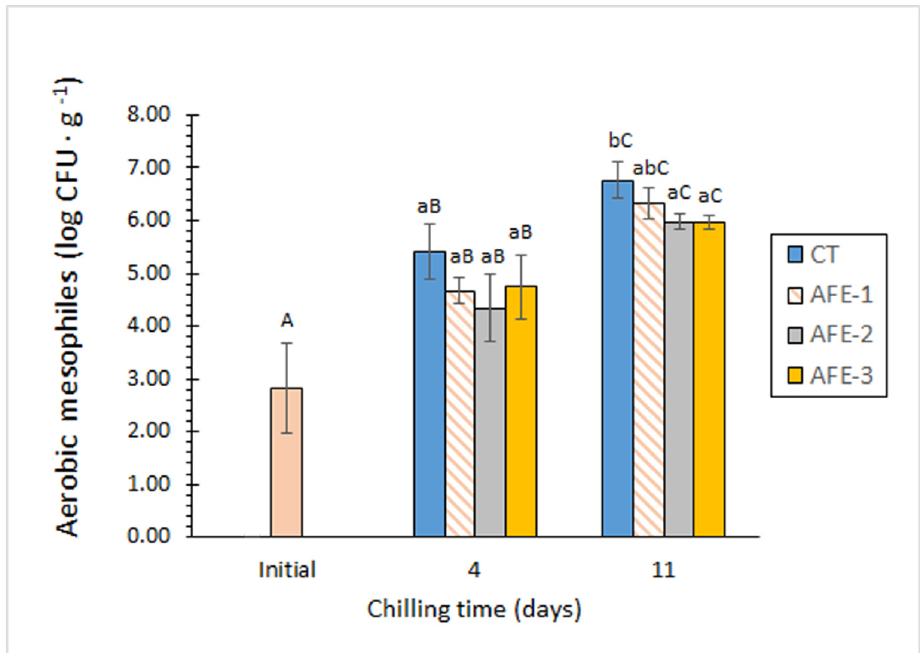
Figure 1. Aerobic mesophiles (log CFU·g − 1 muscle) in chilled mackerel subjected to different icing conditions. Mean values of three replicates ( n = 3); standard deviations are expressed by bars. Mean values accompanied by different lowercase letters (a, b) denote significant differences ( p < 0.05) as a result of icing conditions; mean values accompanied by different capital letters (A–C) denote signif- icant differences ( p < 0.05) as a result of storage time. Icing conditions: CT (control; ice prepared without alga flour extract); AFE-1, AFE-2, and AFE-3 correspond to low, medium, and high concen- trations of alga flour extracts, respectively.